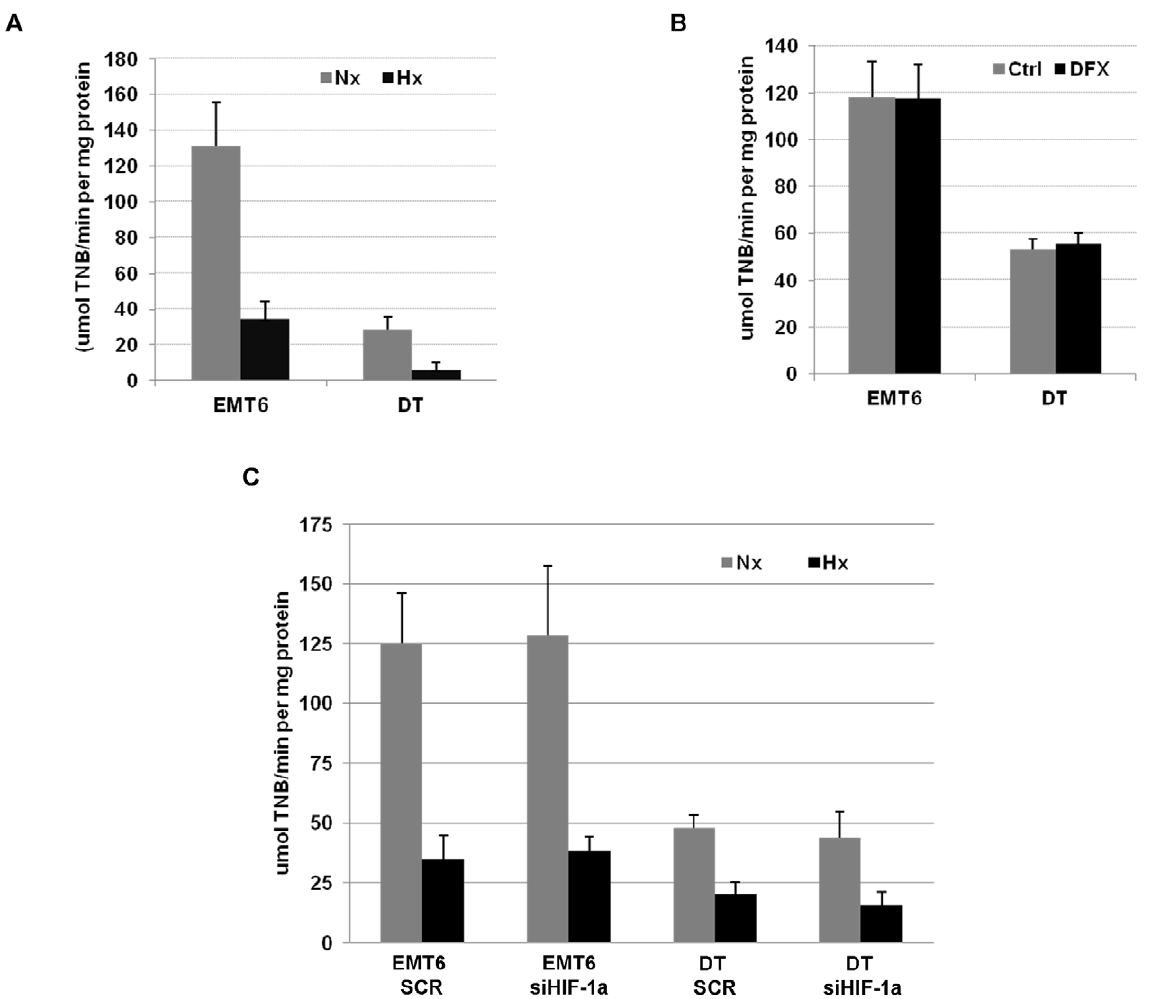
Figure 4. Effect of hypoxic conditions, EGLN inhibitors or HIF-1 a deficiency on TR1 activity. (A) TR1 activity was measured as indicated in Methods in EMT6 and DT cells grown under normoxic (Nx) or hypoxic (Hx) conditions for 12 h. (B) EMT6 and DT cells were treated with 150 m M deferoxamine (DFX) or left untreated (Ctrl) for 12 h and TR1 activity measured. (C) EMT6 and DT cells infected with retrovirus encoding a scramble sequence (SCR) or a HIF-1 a shRNA (si HIF-1 a ) were cultured under normoxic (Nx) or hypoxic (Hx) conditions for 12 h and TR1 activity measured. Data represent the means of 3 independent experiments 6 SE. doi:10.1371/journal.pone.0030470.g004 protein levels (Fig. 5C and 5D) or in the induction of the HIF target genes, VEGF and ADM, in the TR1 knockdown cells compared to the control cells (Fig. 5E and 5F).